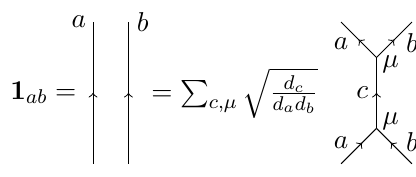
Figure 3 . Resolution of